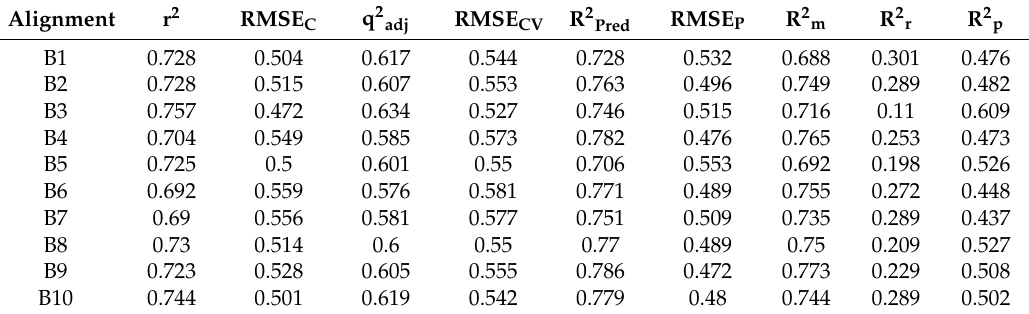
Table 2. Statistical parameters evaluated in the 4D-QSAR analysis for the ten performed alignments of Test